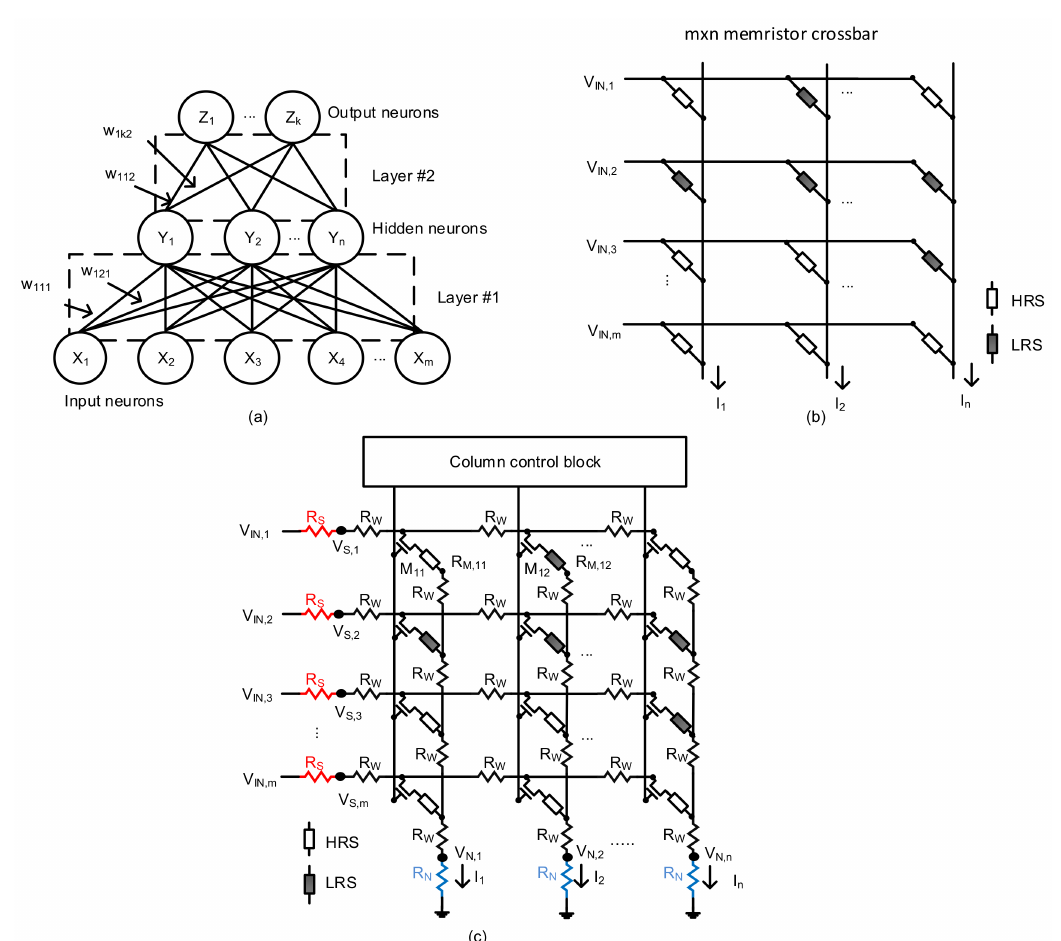
Figure 1. ( a ) Conceptual schematic of two-layer neural network with input, hidden, and output neurons. ( b ) Schematic of ideal memristor crossbar circuit with HRS and LRS memristor synapses. The numbers of rows and columns are ‘m’ and ‘n’, respectively. The parasitic resistance such as source, line, and neuron resistance are assumed zero, in the ideal crossbar. ( c ) Schematic of nonideal memristor crossbar circuit with parasitic crossbar resistance such as source, line, and neuron